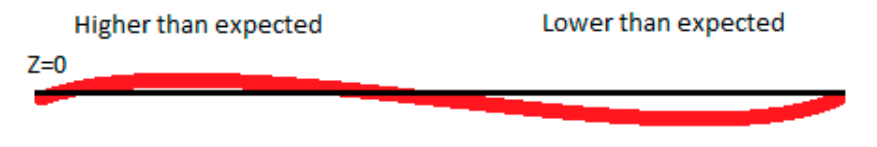
Figure 5. An illustration of substrate deformation.